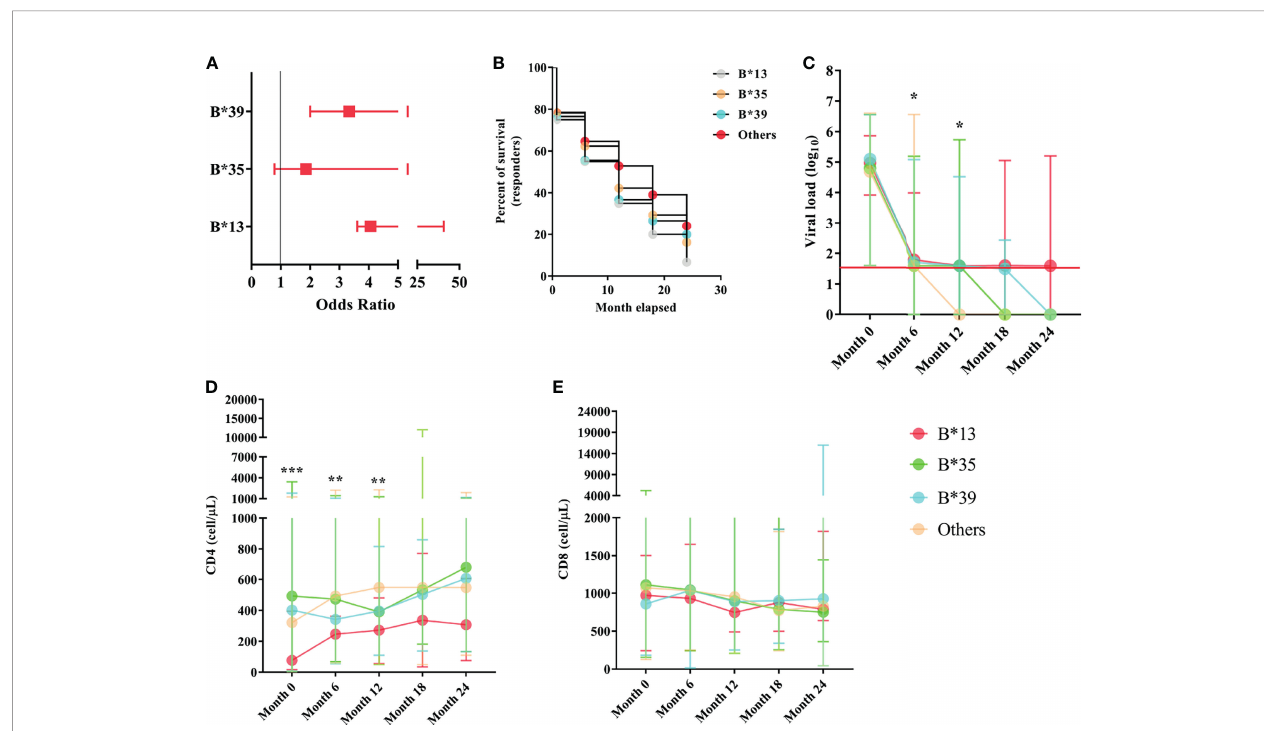
FIGURE 4 | (A) Box plot graph showing the odds ratio values for the risk of therapeutic nonresponse associated with the B*13, B*35 and B*39 alleles. The horizontal bars are the statistical con fi dence interval for each odds ratio. (B) Kaplan – Meier and Mantel-Cox survival curve models for alleles B*13, B*35, B*39 and other alleles related to the proportion of ART responders across 24 months of observation; the proposed curves were signi fi cant (x 2 = 9.923; p = 0.0192); the B*13 allele occurred in the lowest proportion of responders over the study period (6.67%). (C) Longitudinal evaluation of viral load. The red line represents the detection limit of the kit used. (D) CD4+ T lymphocyte count and (E) CD8+ T lymphocyte count among carriers of alleles B*13, B*35, B*39 and other alleles in the 24-month period; *** : p < 0.0001; **: 0.005 ≥ p < 0.0001; * : 0.05 ≤ p >